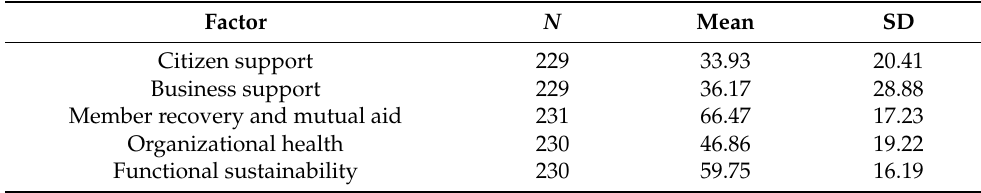
Table 1. Means and standard deviations of the factors in the model.